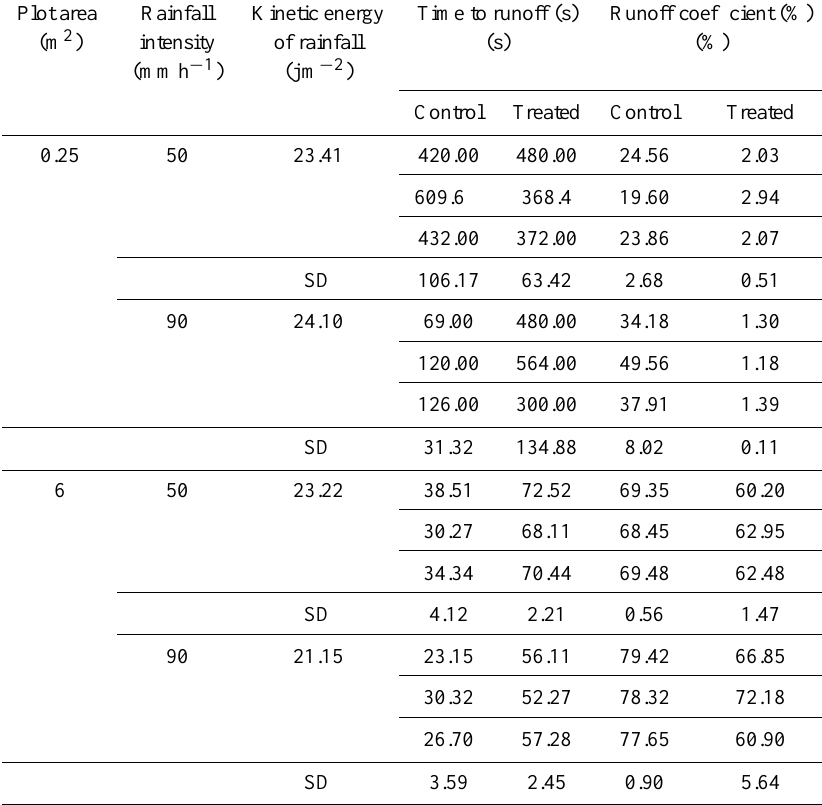
Table 1. Time to runoff and coefficient before and after conservation treatment on study scales.